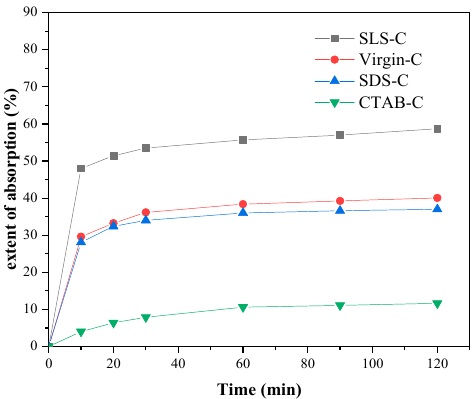
Figure 2. MB removal by using different activated carbons (ACs) (initial MB concentration = 50 mg·L − 1 , S/L = 0.15 g·L − 1 , T = 298 K, pH = 5.0).